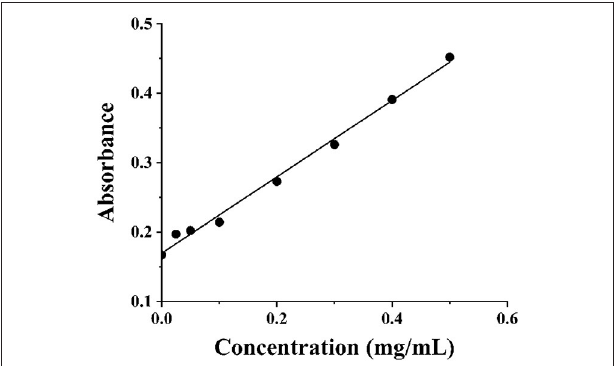
FIGURE 2 | Protein standard